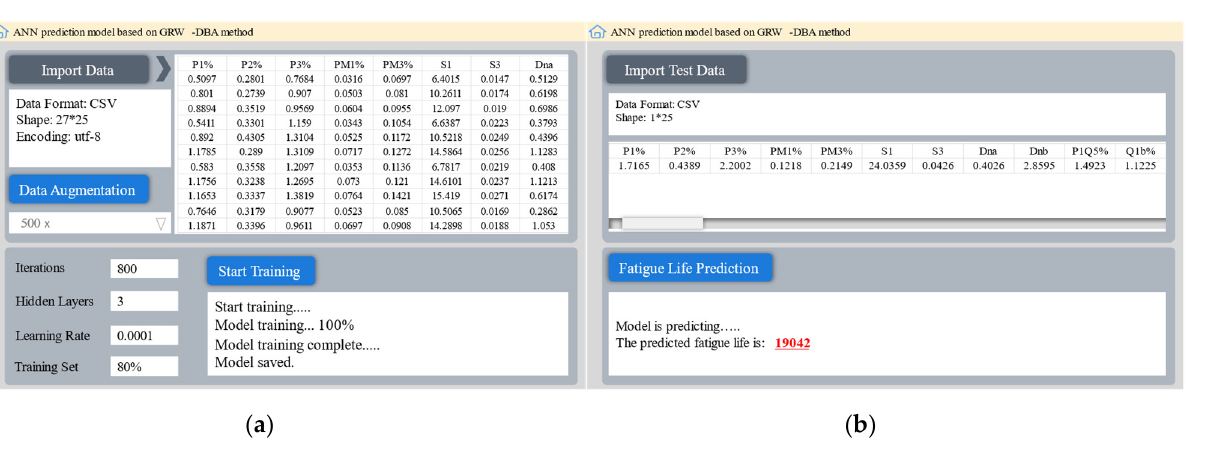
Figure 12. Developed graphical user interface: ( a ) interface 1; ( b ) interface